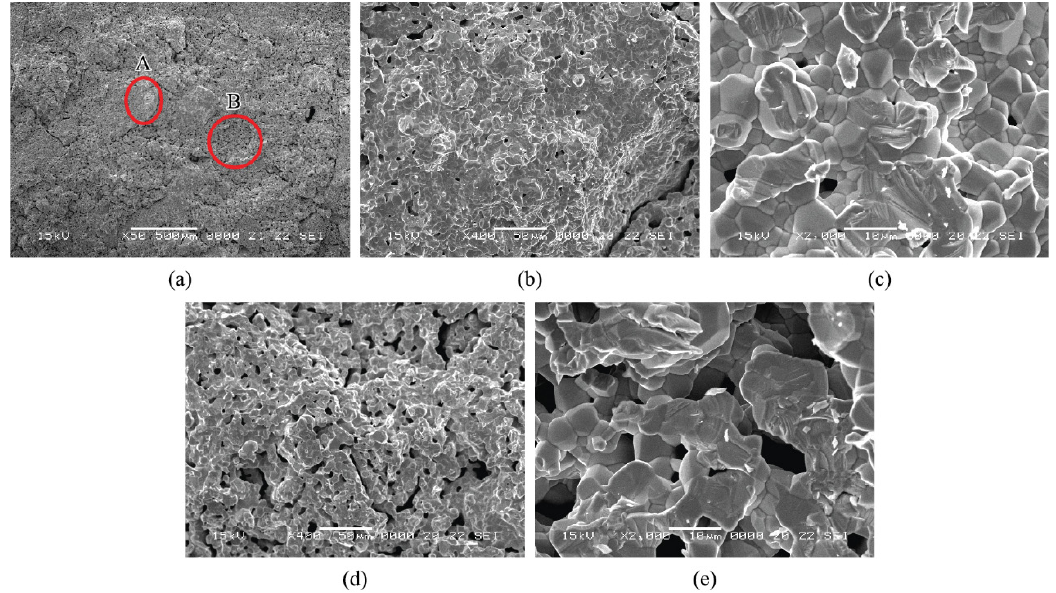
Figure 3. SEM images of the modified ITO tablets: (a) overall view, (b) dense region (region A), (c) magnification of dense region, (d) loose region (region B), (e) magnification of loose region.